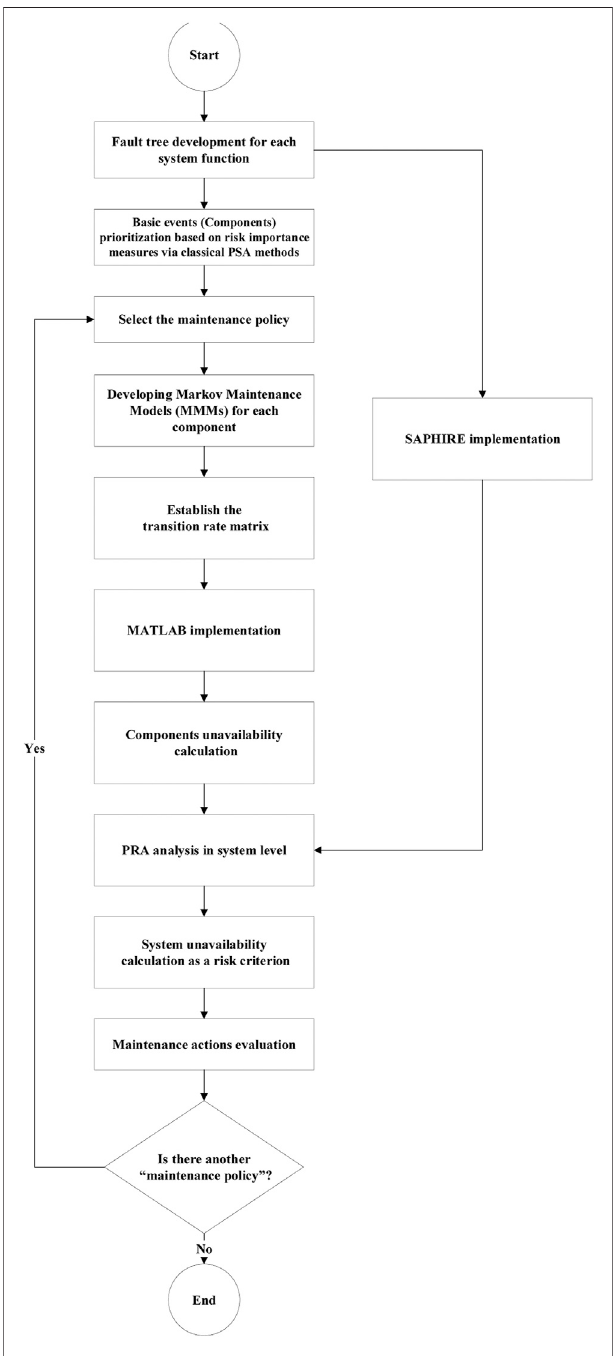
FIGURE 5 | Coupling process of MMMs with the FT method for system unavailability calculation.